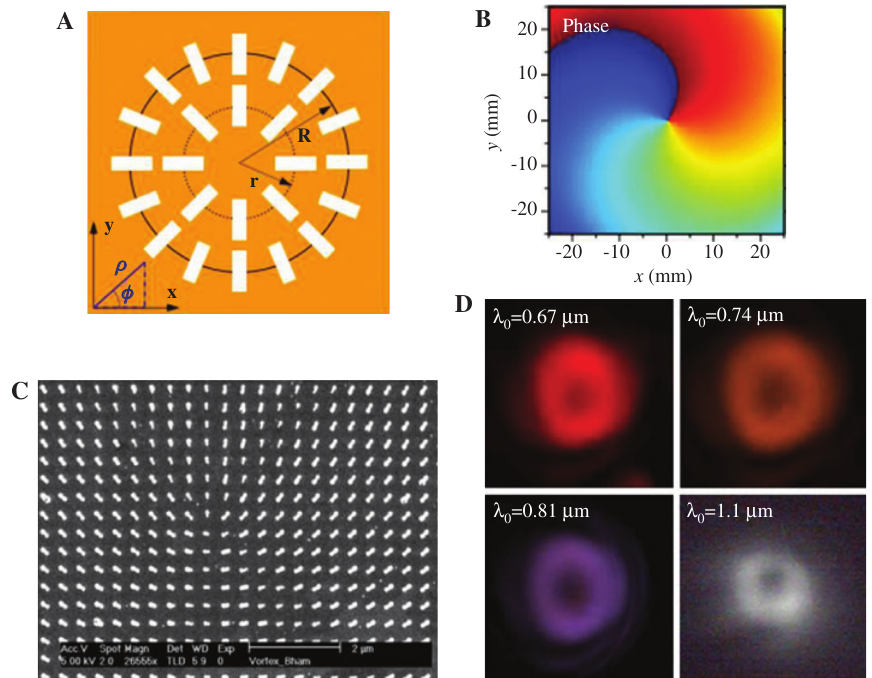
Figure 7: The metasurfaces based on the PB phase scatters. (A) and (B) The schematic and phase distribution of a rectangular apertures comprised metasurface, which serves as a vortex beam generator. Each rectangular aperture can be regarded as a polarizer working at a fixed wavelength. (C) and (D) The SEM image and intensity distribution obtained from a dipolar antenna array. The antennas have the same geometry but varied orientations. Each antenna can be treated as a nano-waveplate. Adapted from Refs. [57,